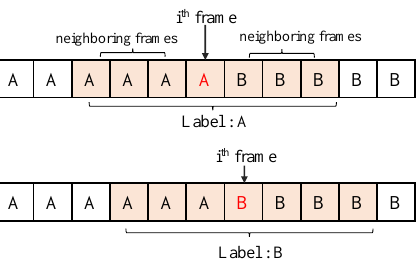
Figure 5. Example of labeling an audio context clip. ( Top ) ith frame corresponds to A chord, and the label of this audio context is A chord. ( Bottom ) ith frame corresponds to B chord, and the label of this audio context is B